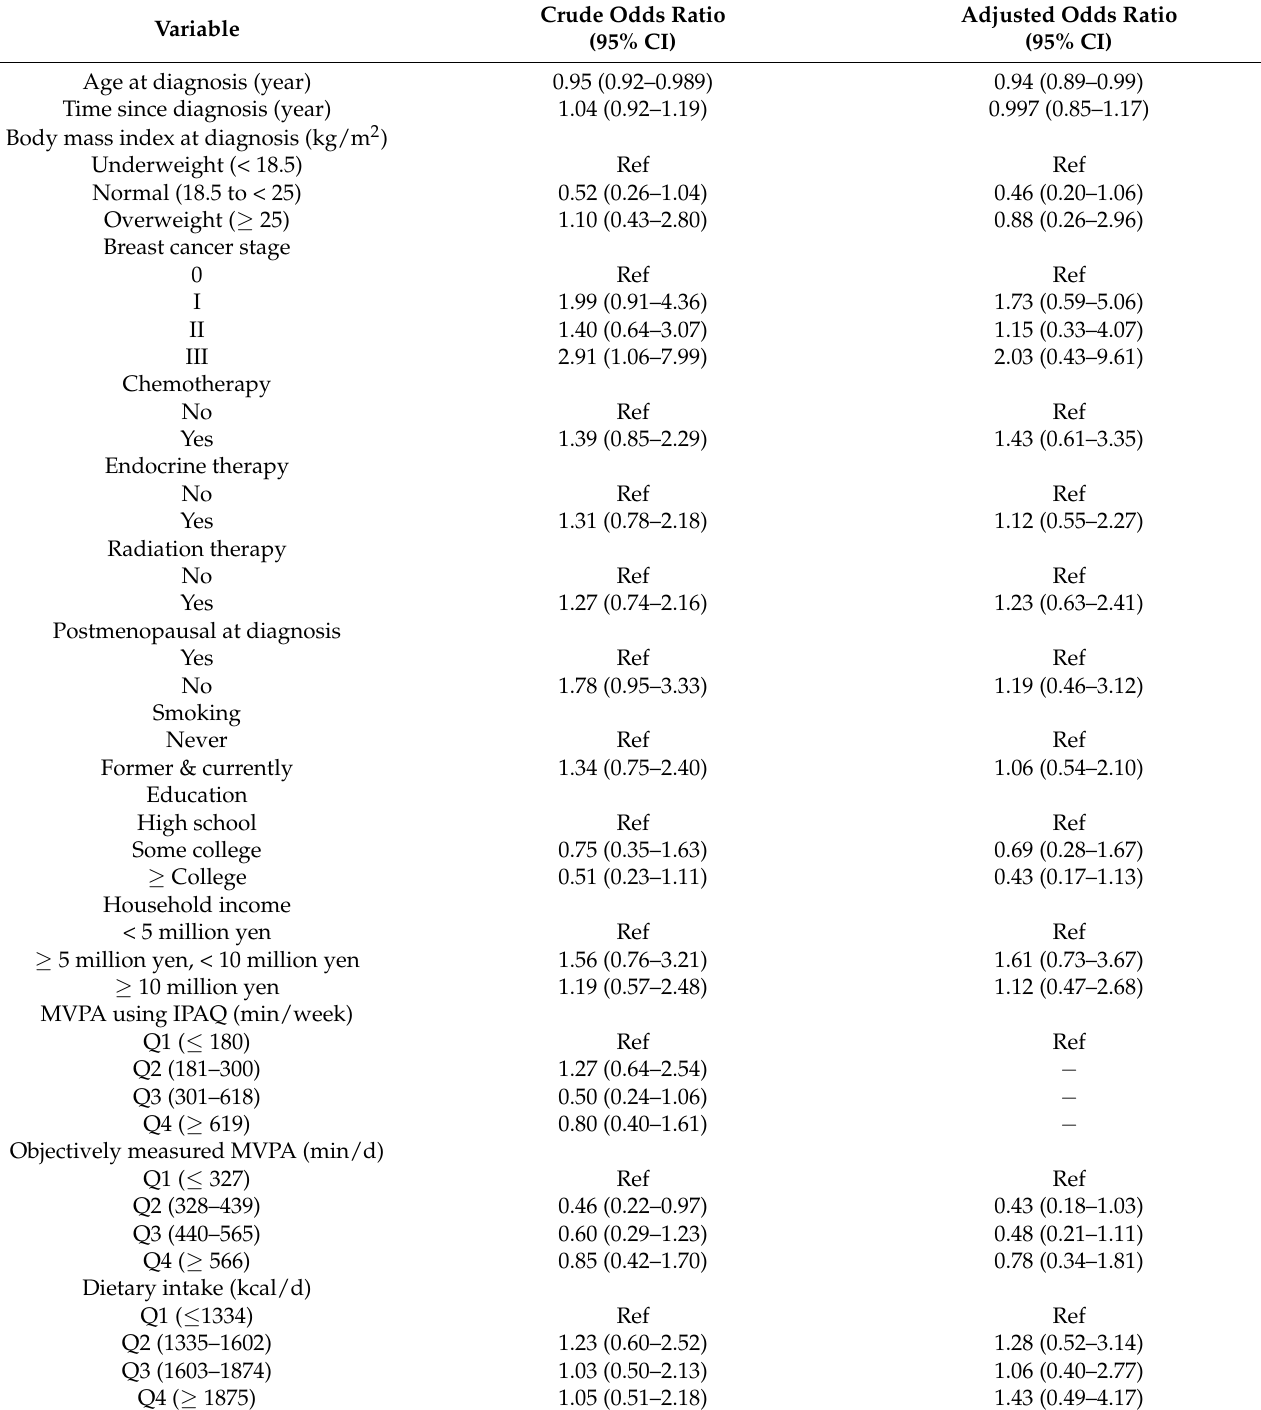
Table 3. Odds ratio for 5% weight gain after